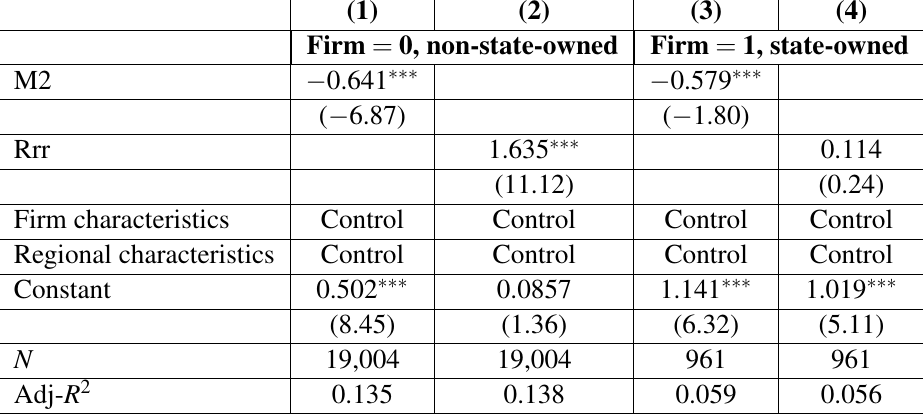
Table 5 Monetary policy and stock pledge with different